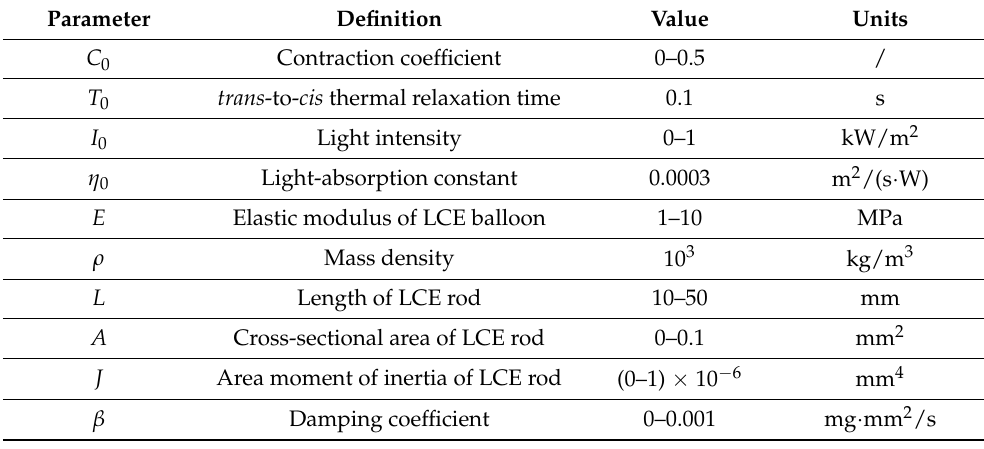
Table 1. Material properties and geometric parameters.